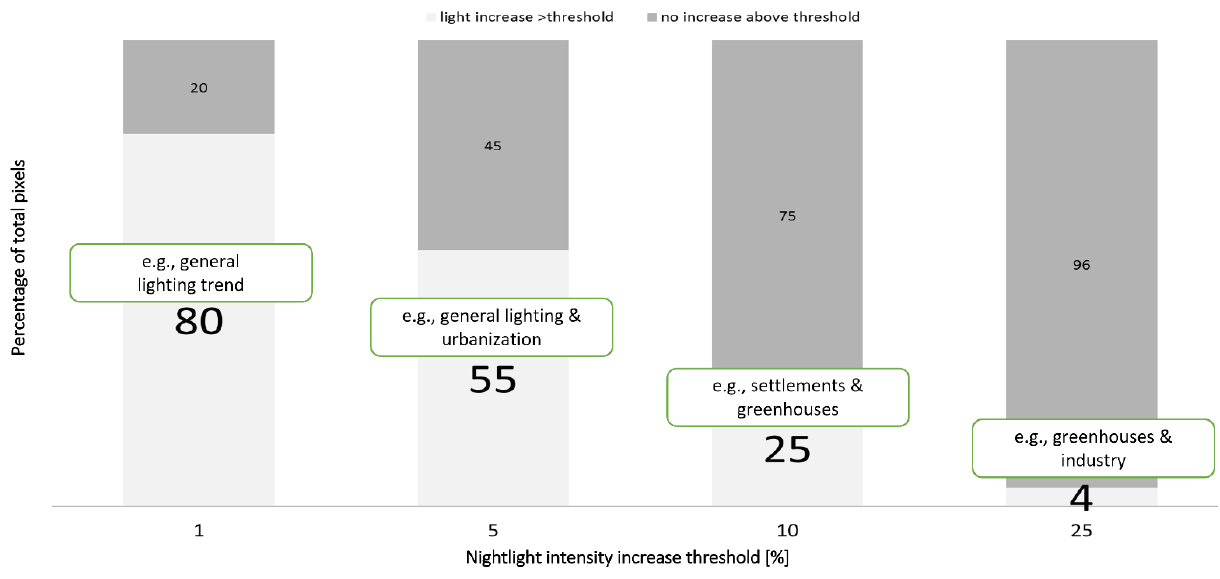
Figure 8. Proportion of pixel increases in nightlight intensity exceeding various percent change thresholds observed between the early (1992 – 1999) and late (2003 – 2010) time periods.